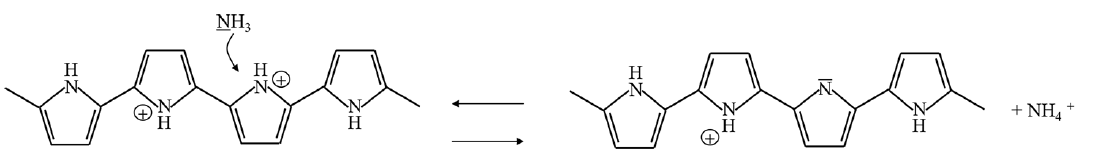
Figure 5. Sensing mechanism of PPy exposed to carbon